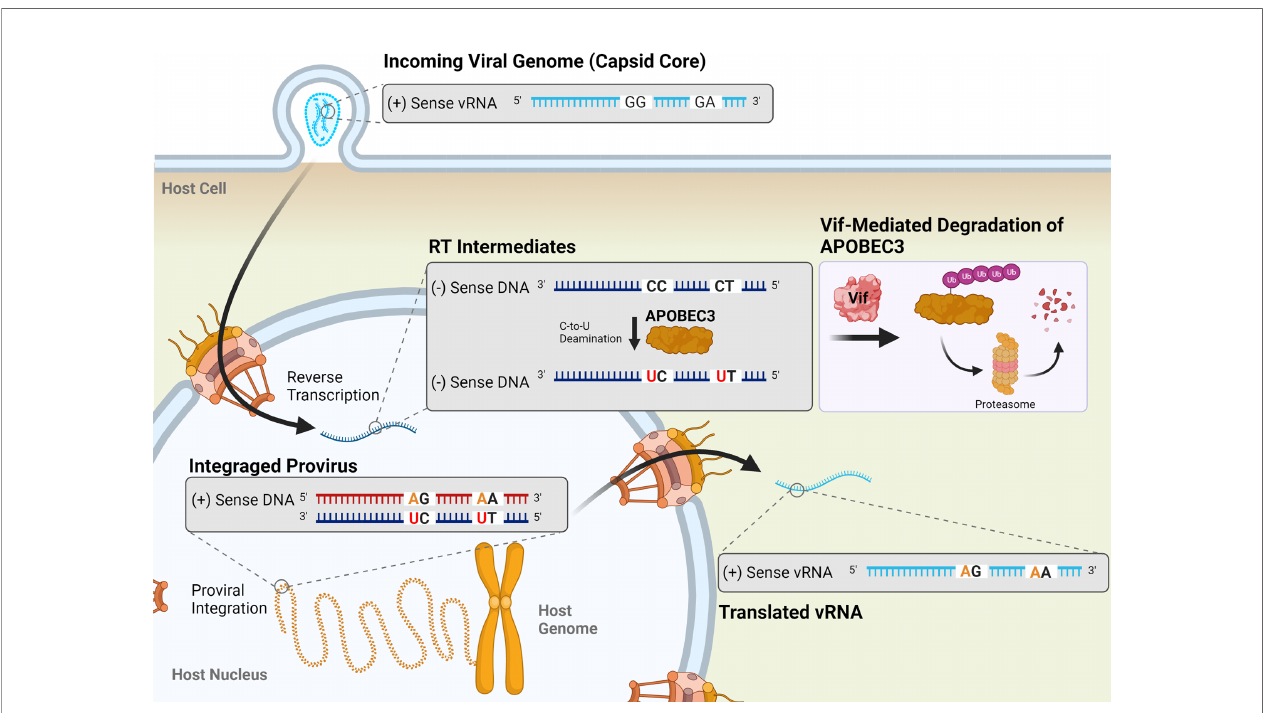
FIGURE 5 | Mutagenesis by APOBEC3 proteins results in G-to-A transition mutations in HIV-1 proviruses. Four APOBEC3 proteins (A3D, A3F, A3G, and A3H) are known to restrict HIV-1 infection by catalyzing the deamination of cytosine in single-stranded DNA (ssDNA) into a uracil (red) during reverse transcription. This templates the improver insertion of an adenine (orange) in place of a guanine, resulting in a G-to-A mutation in the positive-sense DNA strand of the resulting provirus. These mutations preferentially occur in a 5 ’ -GG-3 ’ or 5 ’ -GA-3 ’ dinucleotide context. APOBEC3 activity is inhibited by the viral accessory protein Vif (shown in pink box), which targets APOBEC3 proteins for degradation by the proteasome. Vif suppression of APOBEC3 activity is incomplete, though, and sublethal levels of G-to-A mutations can be observed in HIV-1